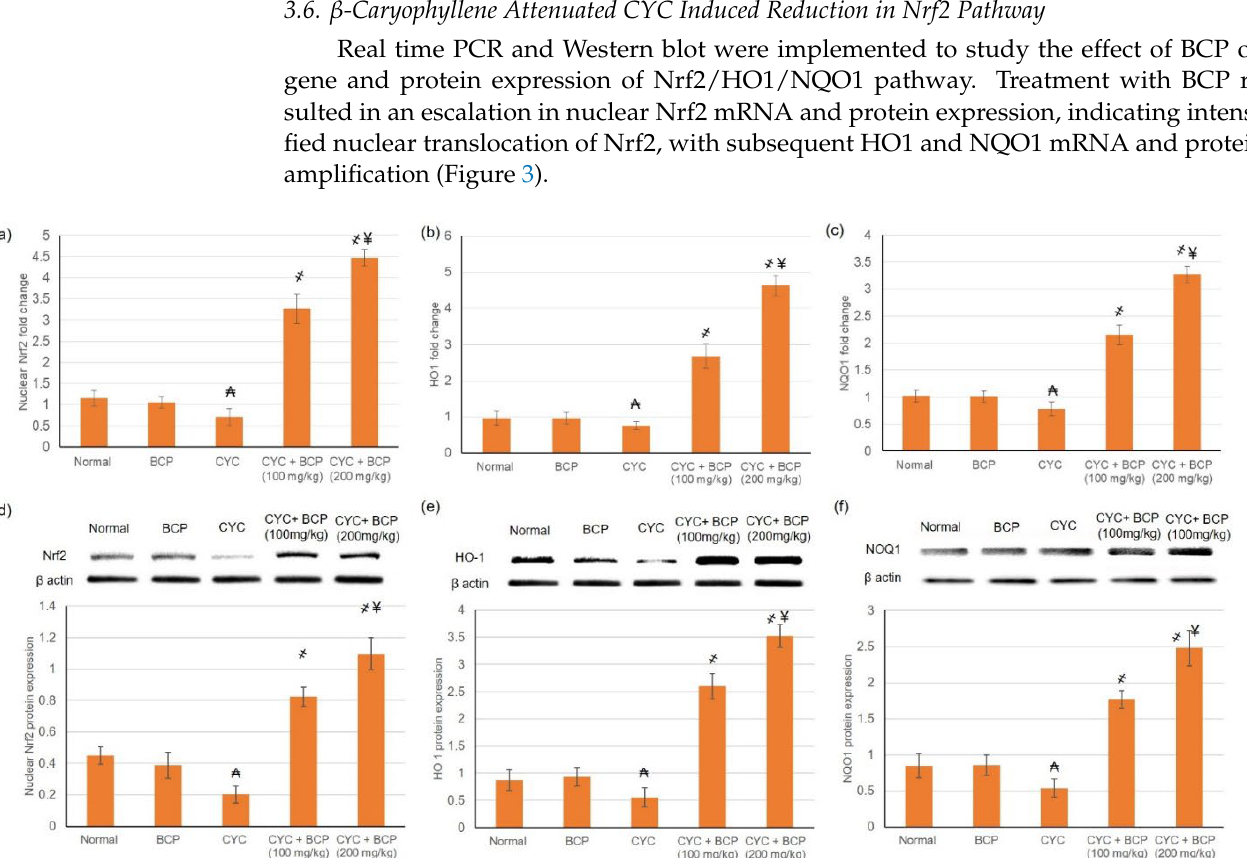
Table 2. Effects of treatment with β -caryophyllene (BCP) for 14 days on cyclophosphamide (CYC) induced fluctuations in ECG and heart rate. Treatment P-R Interval (ms.) R-R Interval (ms.) P-R Interval (ms.) R-R Interval